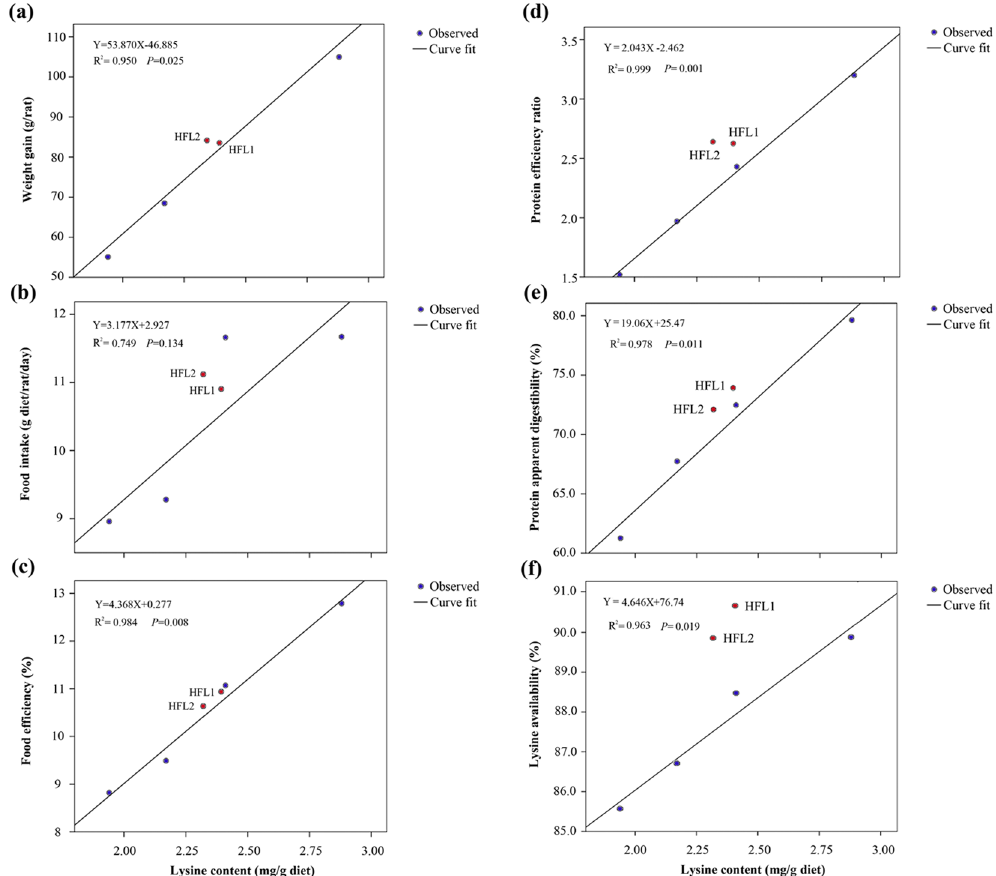
Figure 7. Linear relationship between dietary lysine concentrations and growth biomarkers. The coefficient fitted the value of the linear function. Observed mean values are represented by blue (WT, WT10, WT20, and WT40) and red (HFL1 and HFL2) dots. Solid line represents the fitted dose-response curve. A–F represent the dose-response curve between lysine concentrations and body weight gain ( a ), food intake ( b ), food efficiency ( c ), protein efficiency ratio ( d ), protein apparent digestibility ( e ), and lysine availability ( f